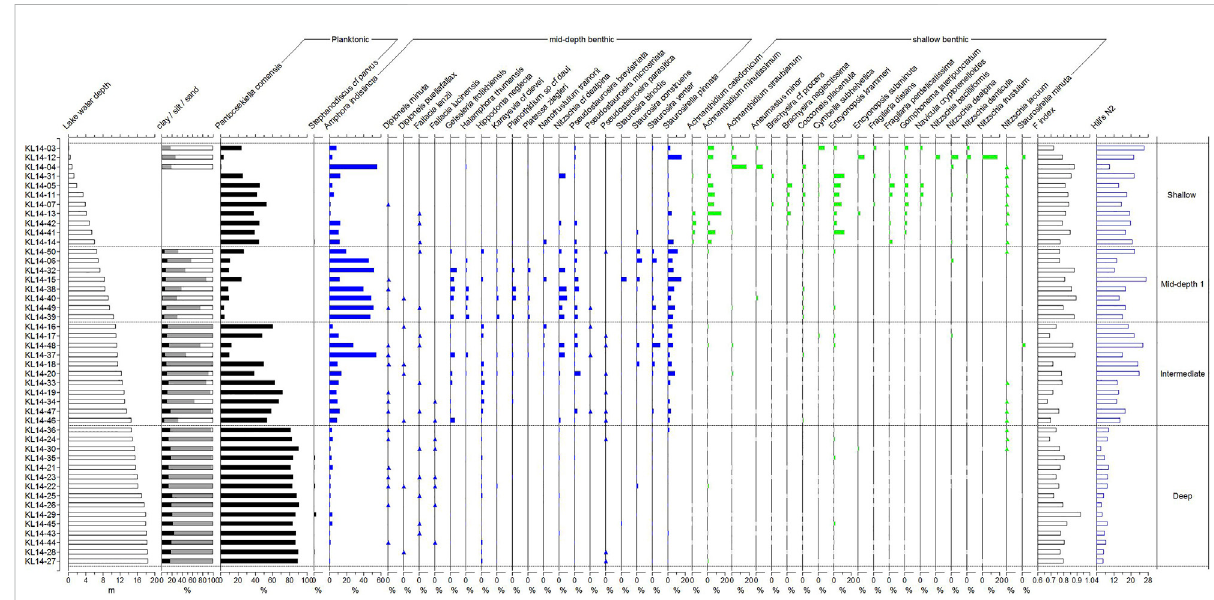
FIGURE 2 Relative percentages of the most abundant diatom taxa, F-index and Hill ’ s N2 index recorded in the surface sediment samples along the water depth gradient and the grain size data (i.e., percentages of clay, silt and sand). The dotted lines represent the diatom communities identi fi ed using cluster analysis (TWINSPAN). The intermediate zone includes samples belonging to the mid-depth and deep communities. Diatom taxa are ordered according to their observed distribution across the water depth gradient: on the left hand-side, in black, are planktonic taxa, in blue are benthic taxa occurring mostly in the mid-depth zone and in green are benthic taxa that mostly occur in the shallow, littoral